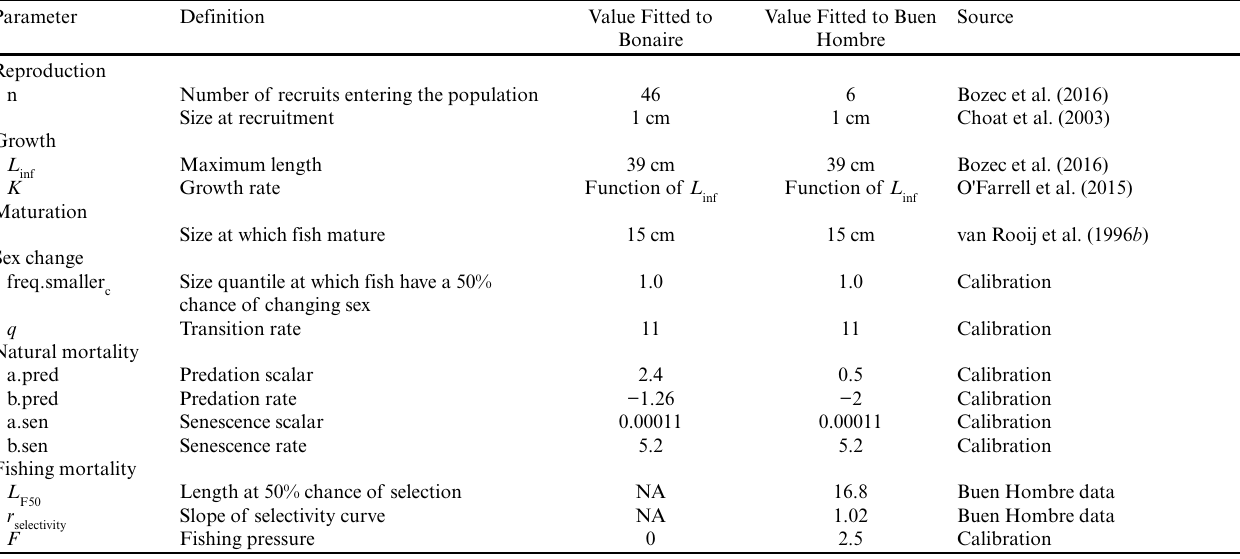
Table 2 . Parameter definitions and values from our model when fitted to an unfished fishery (Bonaire; Pavlowich et al. 2018) and a heavily fished fishery (Buen Hombre). "NA" stands for “not applicable,” which applies to model parameters for fishing mortality that were not present in the model of the unfished Bonaire population.